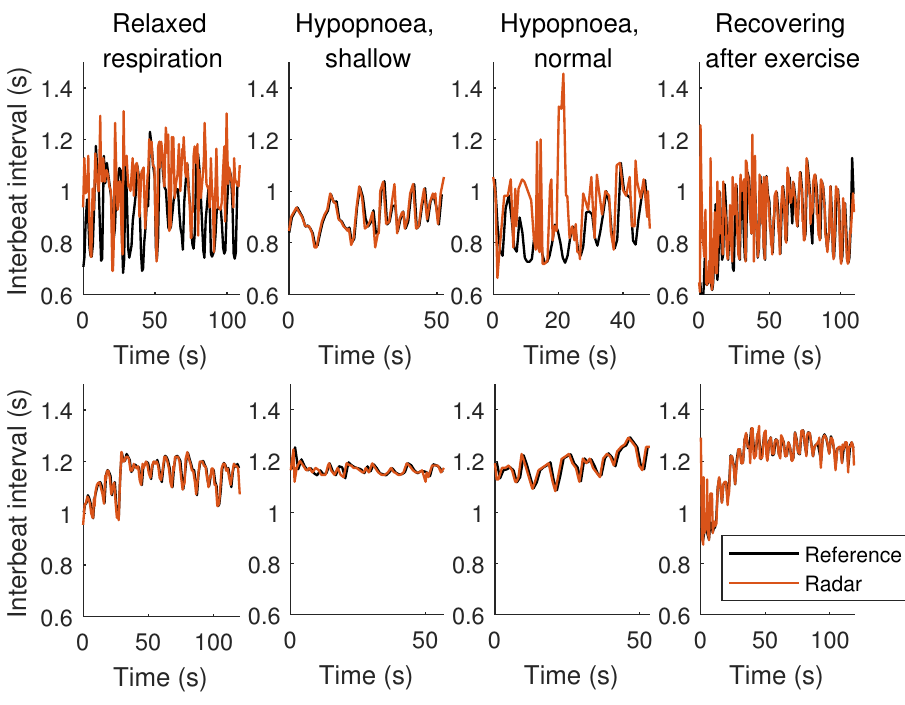
Figure 6. Interbeat interval samples of two participants (ID003 on the top, ID011 on the bottom) for each activity in the supine lying position.